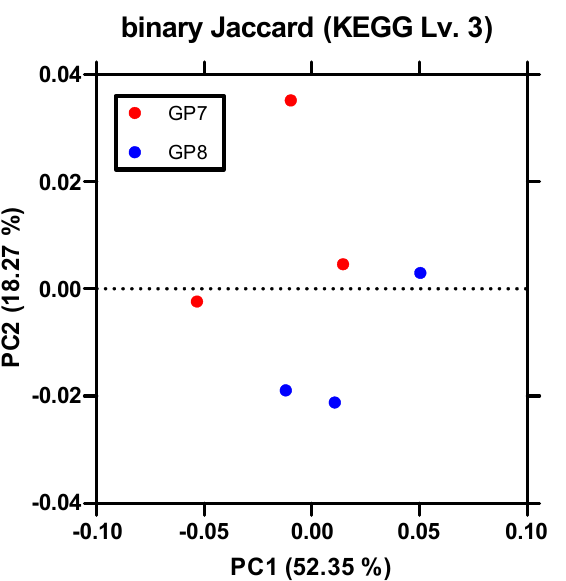
Figure 7. Principal coordinates analysis (PCoA) of PICRUSt_KEGG scattering according to the Binary Jaccard algorithm with PC1 and PC2 explaining 52.35% and 18.27% of the variance, respec- tively.